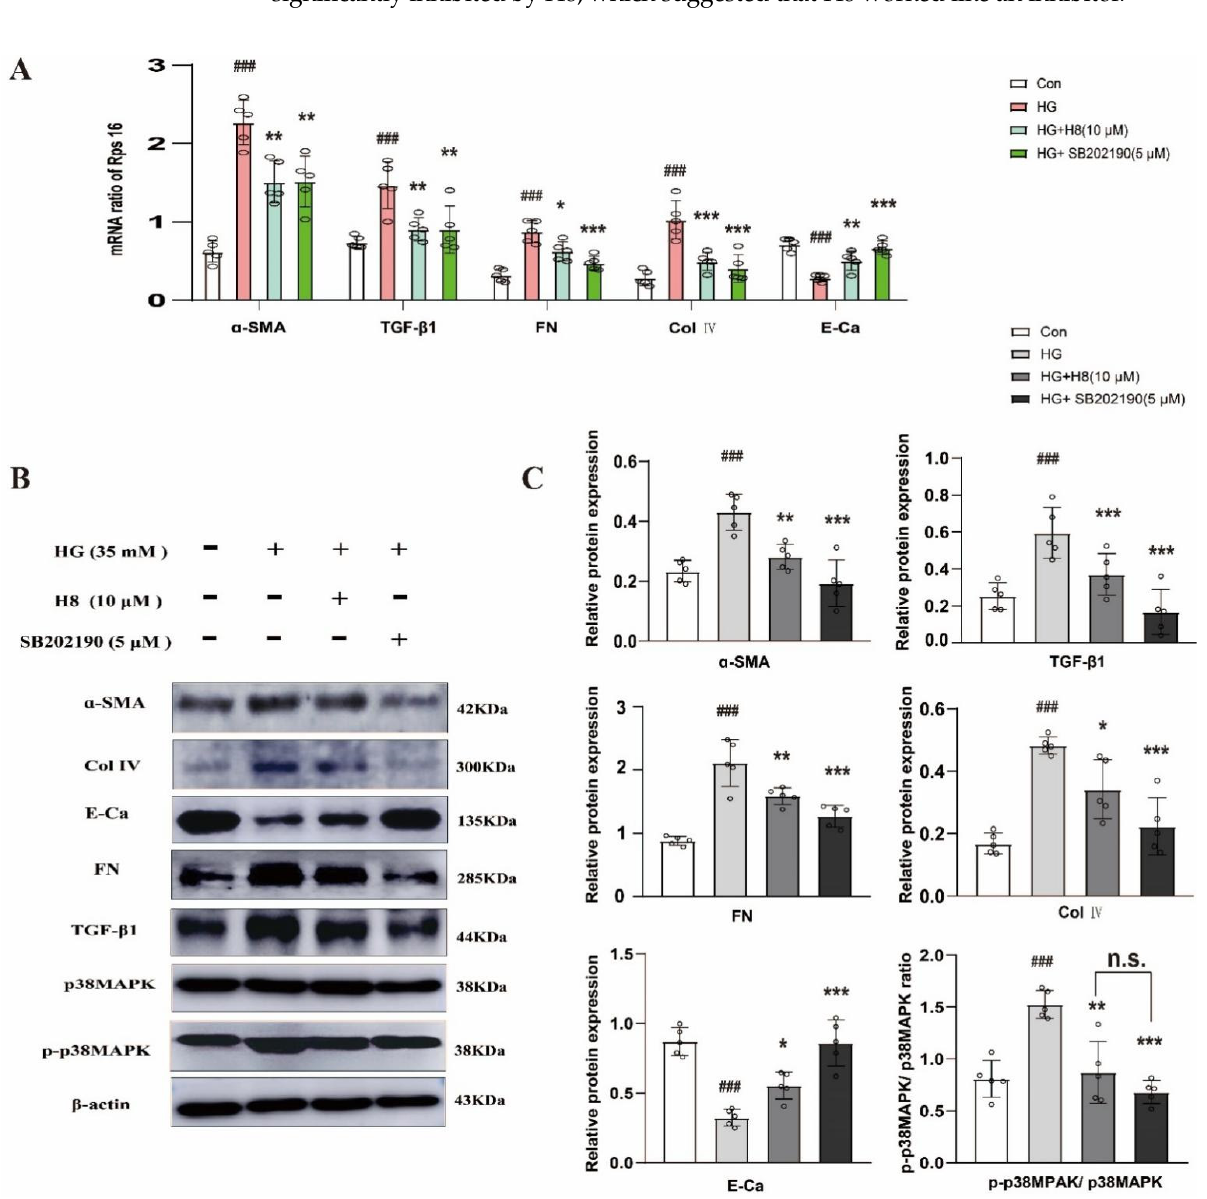
Figure 2. H8 reduced the excessive expressions of ECM in HG-stimulated HK-2 cells, which was related to p38MAPK. ( A ) The mRNA expression levels were examined by qPCR, and the values were normalized to rps16 ( α -SMA, TGF- β 1, FN, Col IV, and E-Ca). ( B ) Western blot band. ( C ) The protein relative expression levels ( α -SMA, TGF- β 1, FN, Col IV, E-Ca, and the ratio of P- p38MAPK/p38MAPK). Data are shown as mean ± S.D. ( n = 5). ### p < 0.001 compared to Con group; * p < 0.05, ** p < 0.01, and *** p < 0.001 compared to HG group; n.s. represents no significant difference in statistics.